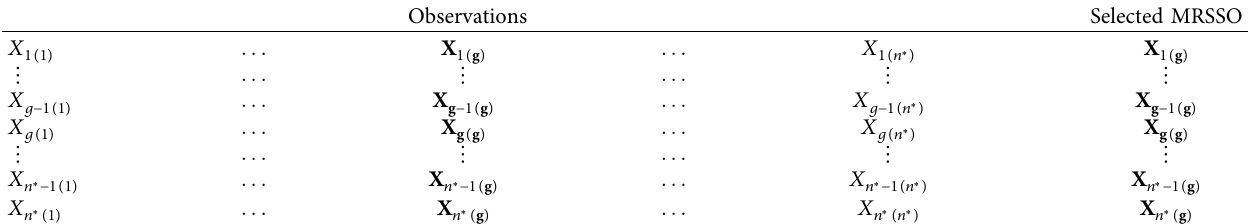
Table 2: MRSS for odd set size